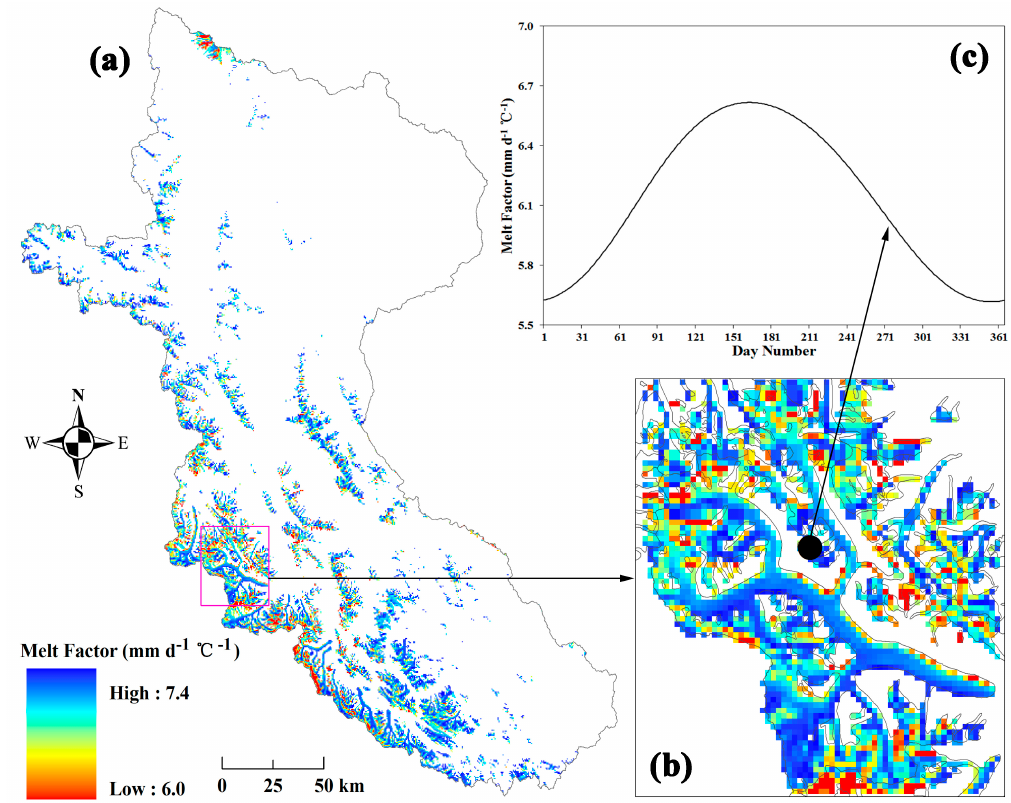
Figure 3. The spatial and temporal variation of ice melt factor; ( a ) The spatial distribution of ice melt factor for the 182nd day in a year; ( b ) The partial enlarged drawing; ( c ) The temporal variation of ice melt factor for the representative dot in a year. Table 2. Calibrated parameters and their optimized